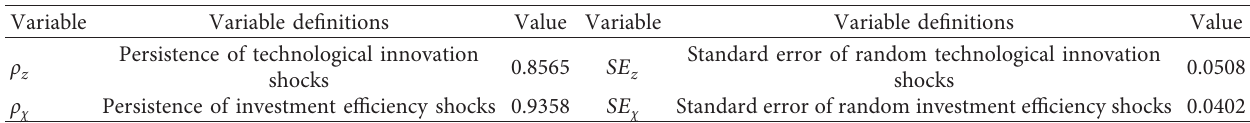
Table 6: Estimated dynamic